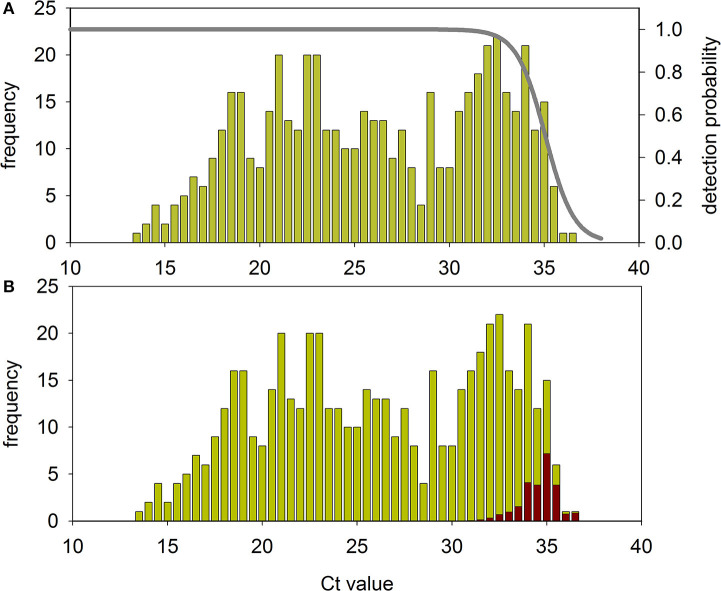
Robustness of the pool method. (A) Histogram of the 526 initial diagnostic samples and probability of their individual detection in a 20 samples pool in experiments performed as depicted in Figures 2, 3. (B) The same histogram indicating the fraction of samples that will be not detected in a 20 samples pool (red bars).